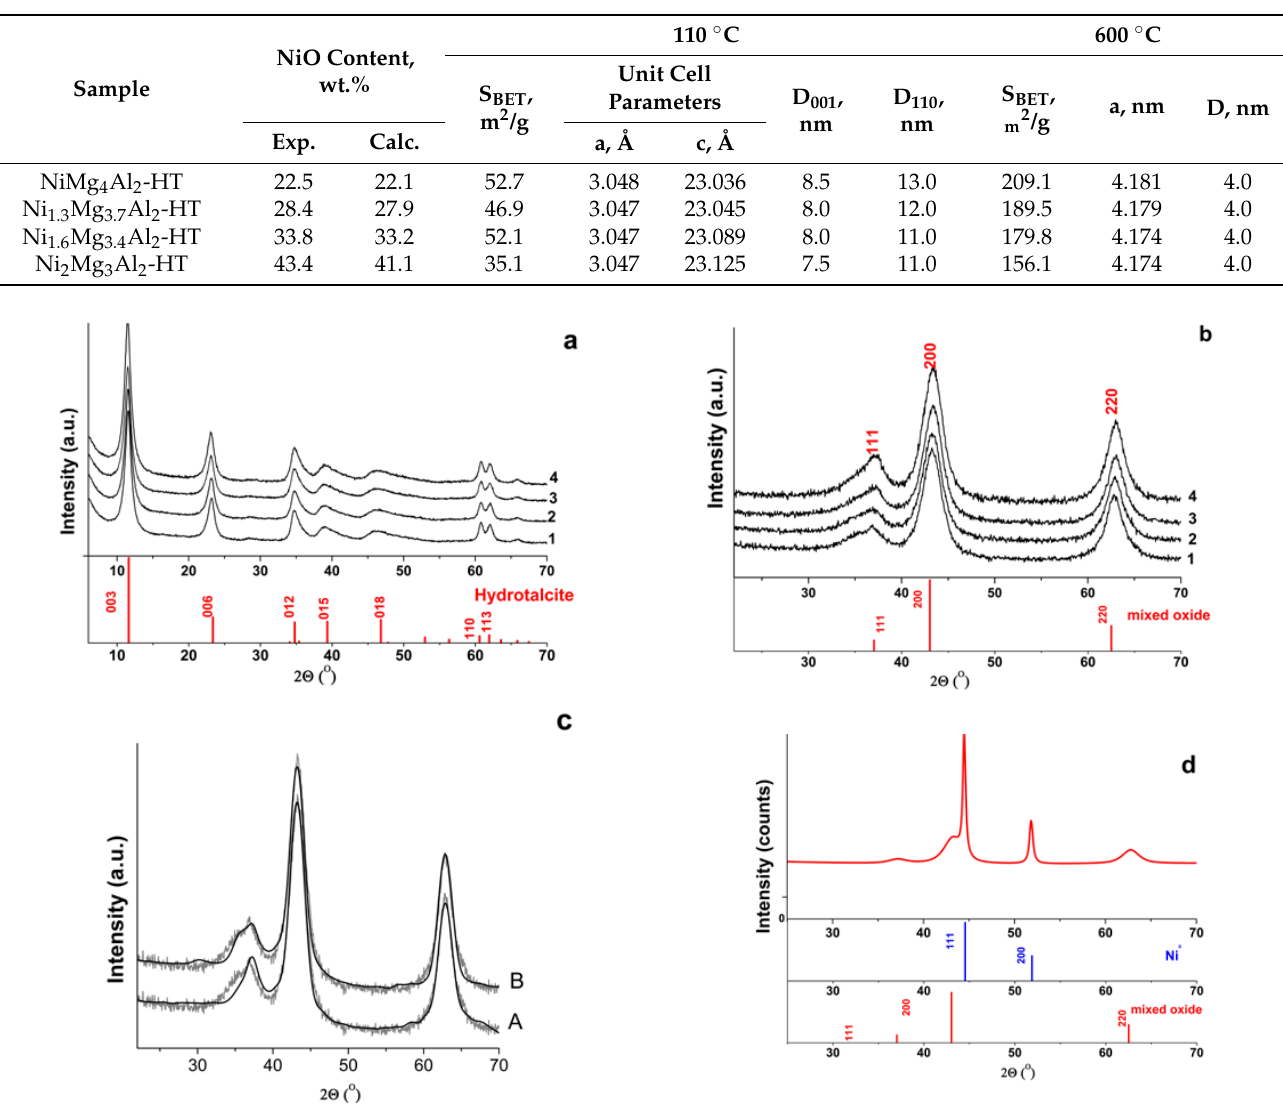
Sample Table 1. Composition and X-ray diffraction data for the dried and calcined samples.